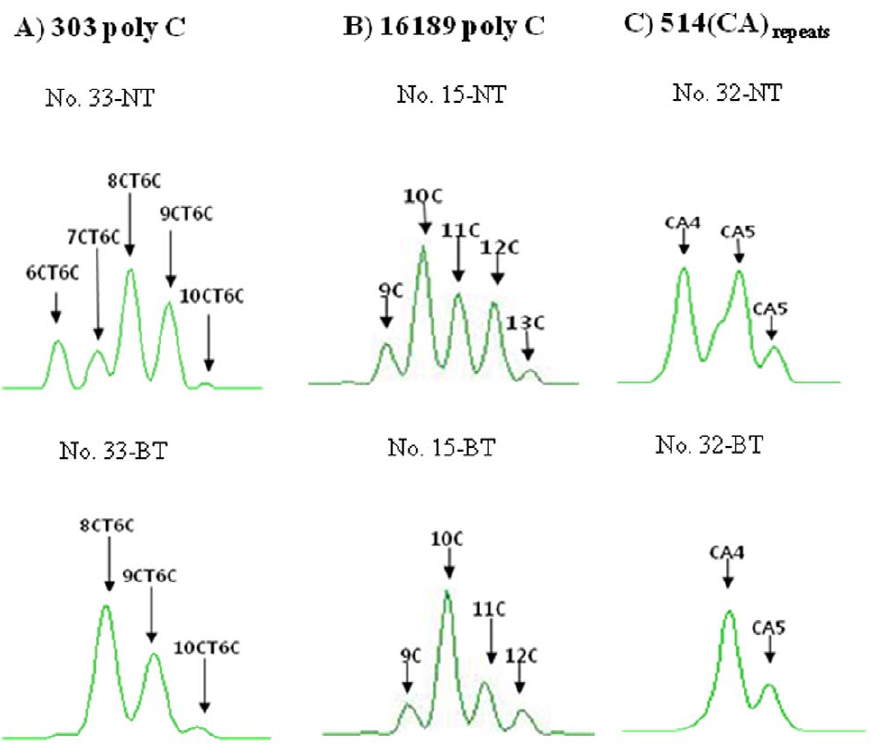
Figure 2. mtDNA length heteroplasmic mutations in Barrett’s metaplasia tissue. A gene scan analysis of the poly C stretch region at nucleotide position (np) 303 - 315 (A), np 16184 - 16193 (B) and (CA) repeat starting at np 514 (C) from Barrett’s metaplasia tissues (BT) compared to those from adjacent normal mucosal tissue (NT) demonstrated typical length heteroplasmic mutations in the poly C stretch regions from patient’s No. 33, 15 and 32 respectively.